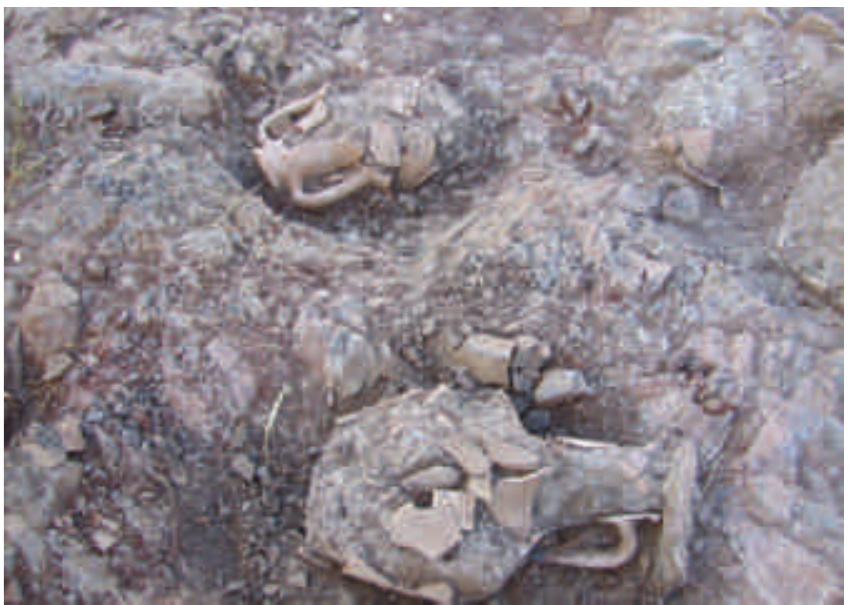
Figure 6 Pots lying in situ at the Kylindra infant cemetery